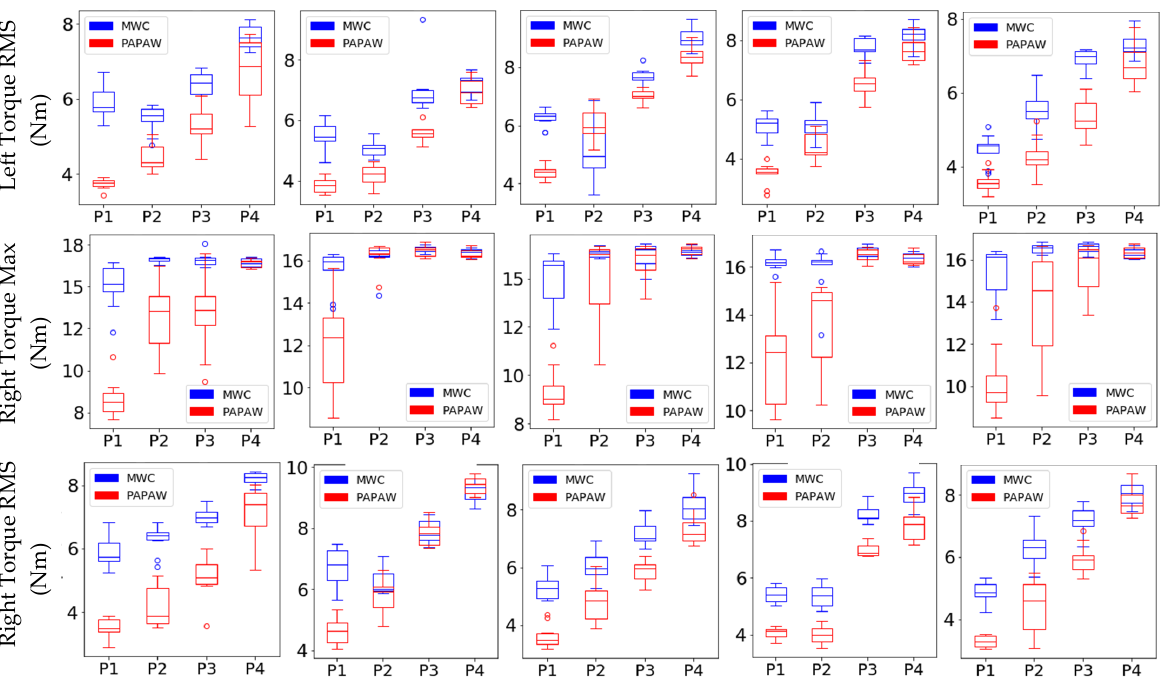
Figure 5. Summary of kinetic characteristics for all wheelchair maneuvers. Each box extends from the Q1 to Q3 quartile values of the data, with a line at the median (Q2). The whiskers extend from the edges of the box to show the range of the data. Outliers are plotted as separate dots.